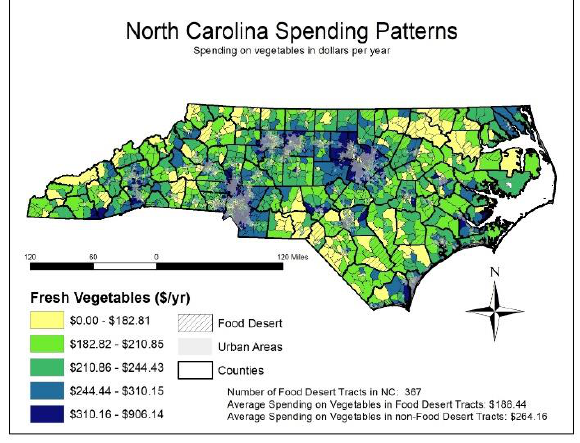
Figure 2: Spatial differences in fresh vegetable consumption in North Carolina . Data Sources: ESRI's 2019 U.S. Consumer Spending Database (originally from BLS) and USDA Food Desert